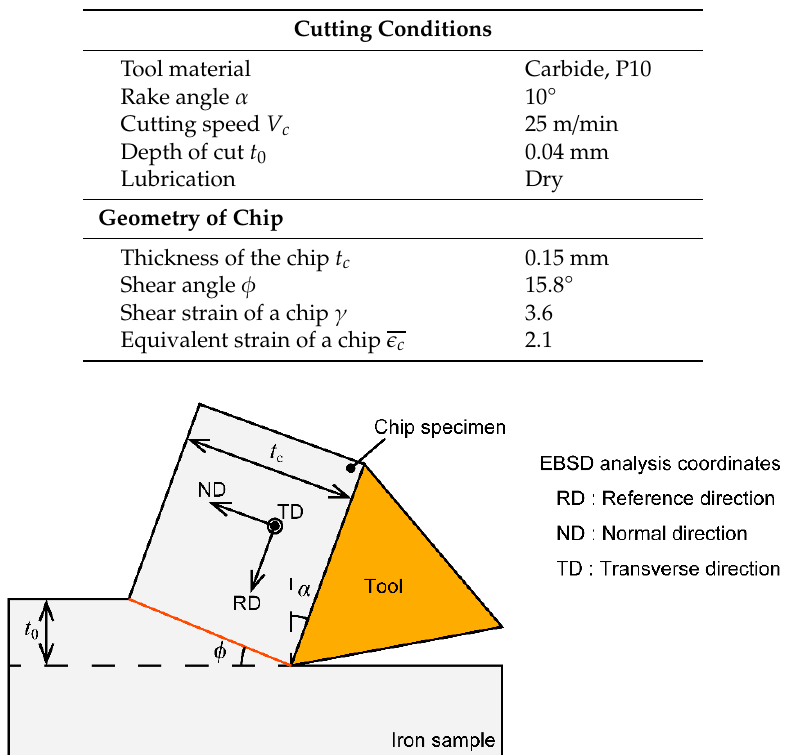
Table 1. Cutting conditions and geometry of the chip specimens.